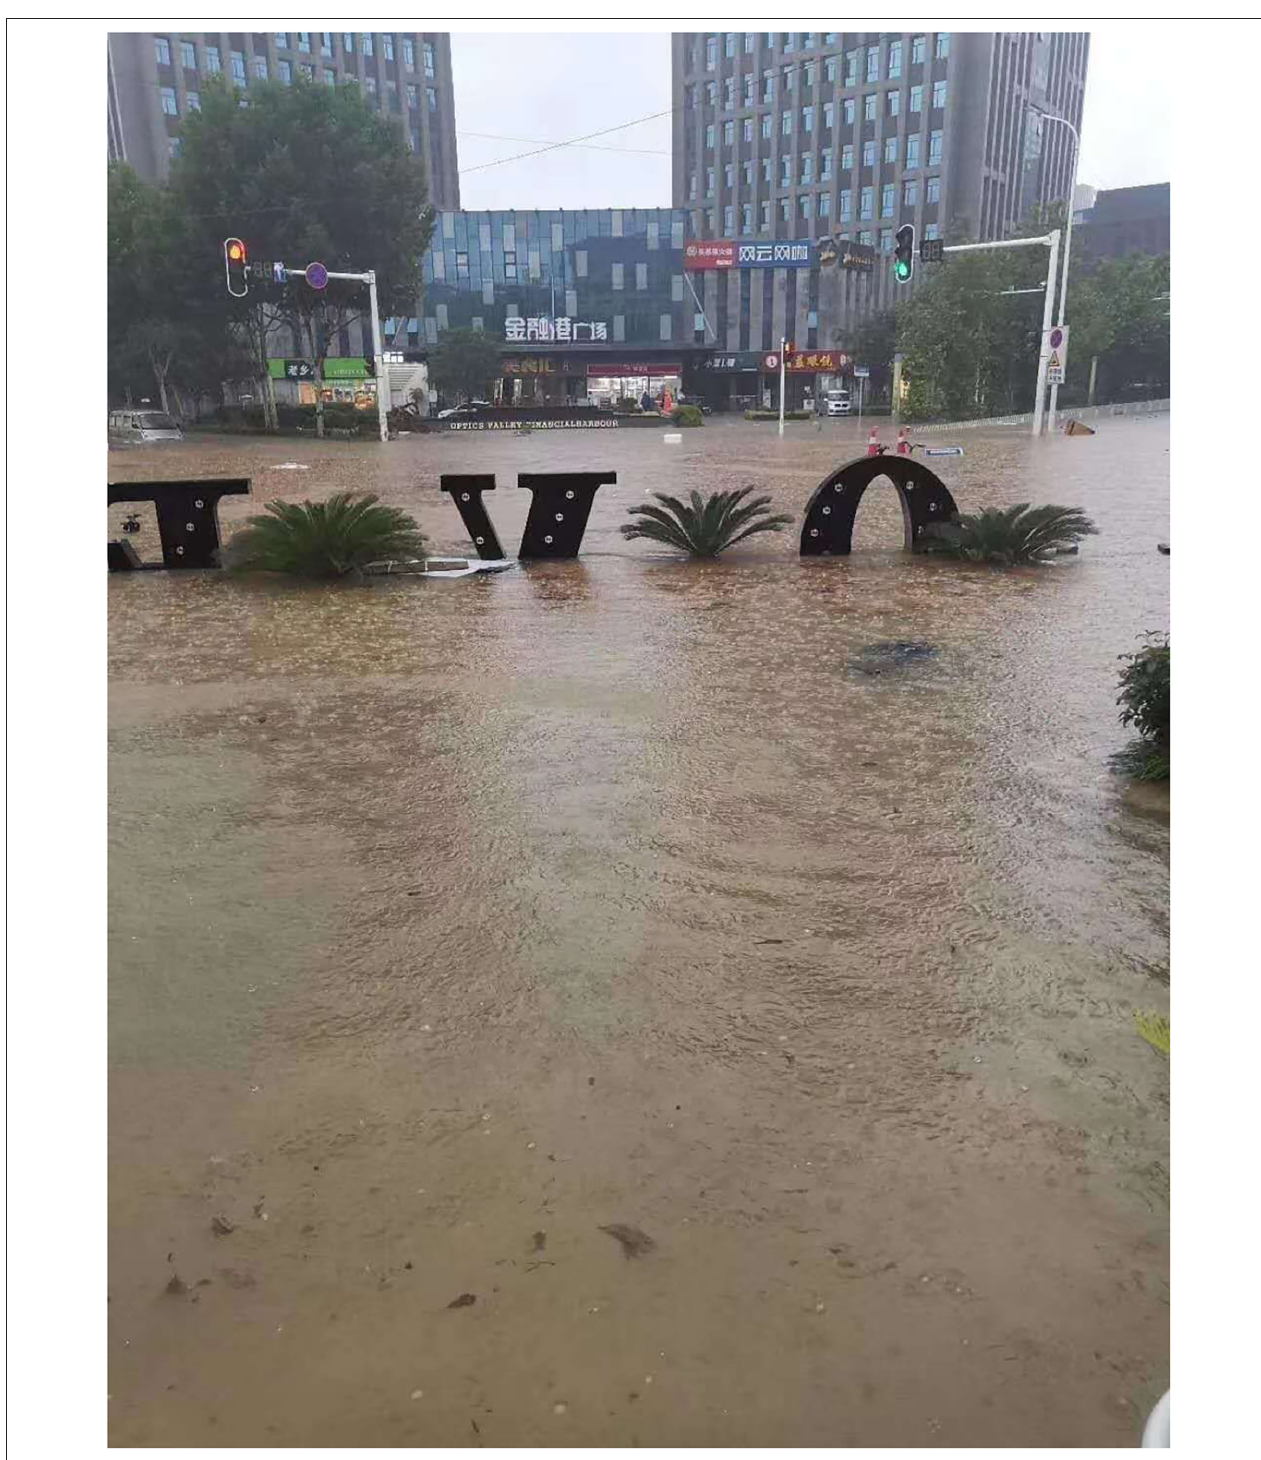
FIGURE 1 | Urban flood at Wuhan on 6–7 July 2021 after intensive rainfall. Source (authors).